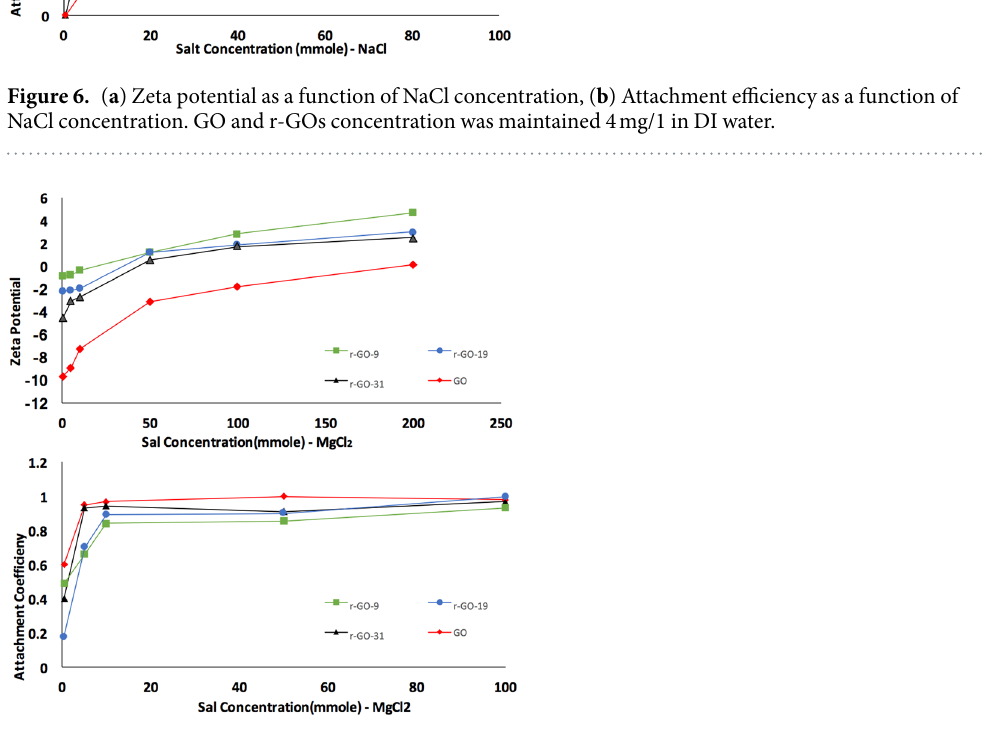
Figure 7. ( a ) Zeta potential as a function of MgCl2 concentration; ( b ) Attachment efficiency as a function of MgCl2 concentration. GO and r-GOs concentration were maintained 4 mg/1 in DI